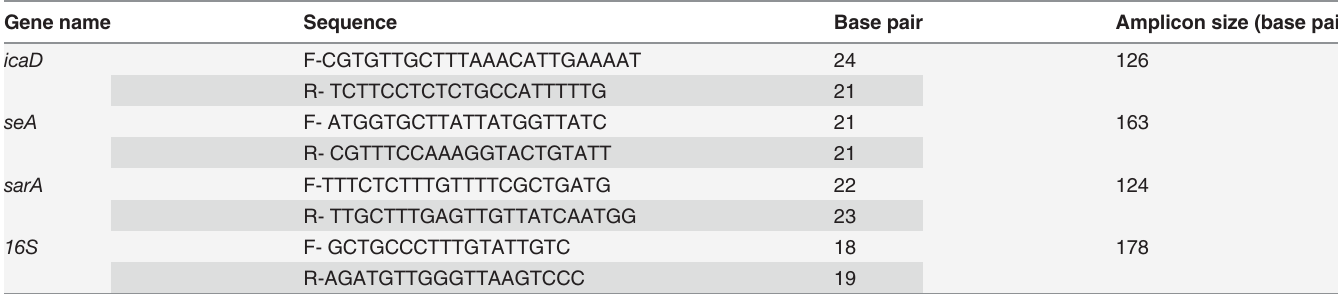
Table 1. List of primers used for gene expression study. Gene name